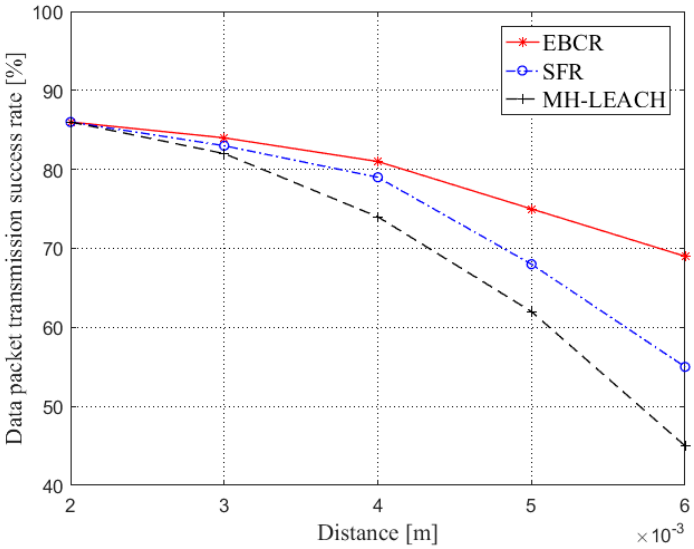
Figure 12. Comparison of the data packet transmission success rate (distance).